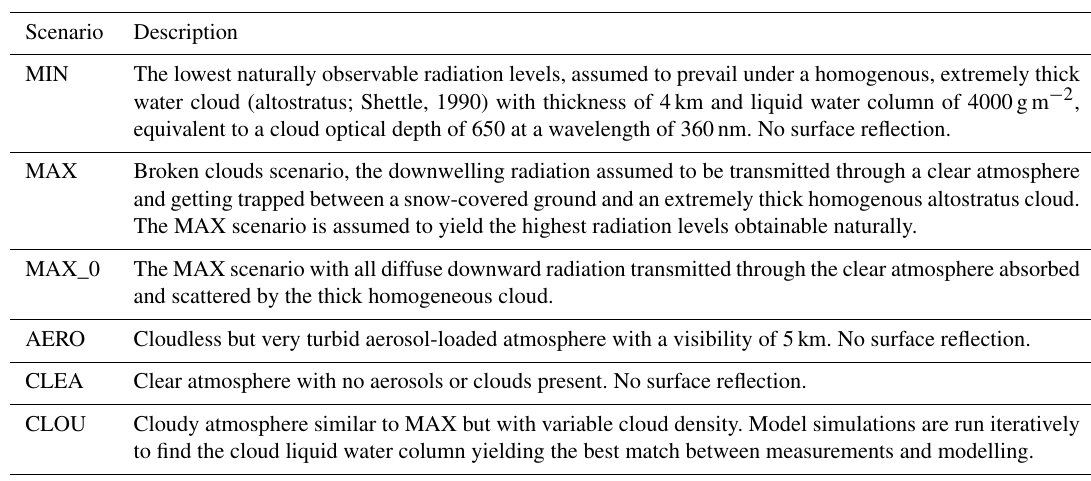
Table 2. Atmospheric scenarios defined in and used by the QA tool AtmosphericSignature.